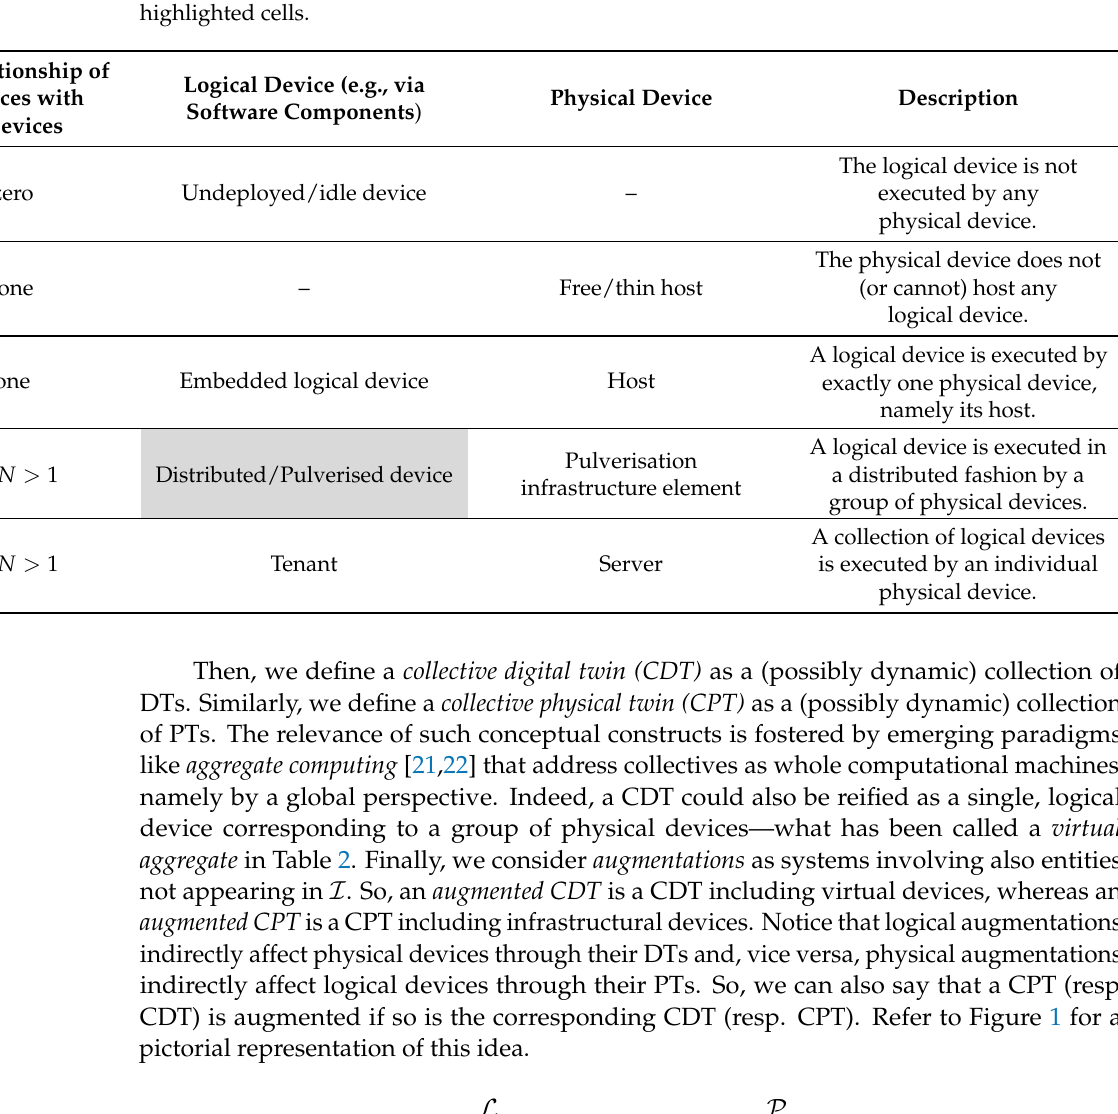
Table 3. Different execution relationships between cyber and physical nodes help us derive dif- ferent concepts (and corresponding terms). This paper has an explicit focus on the notions in the highlighted cells.